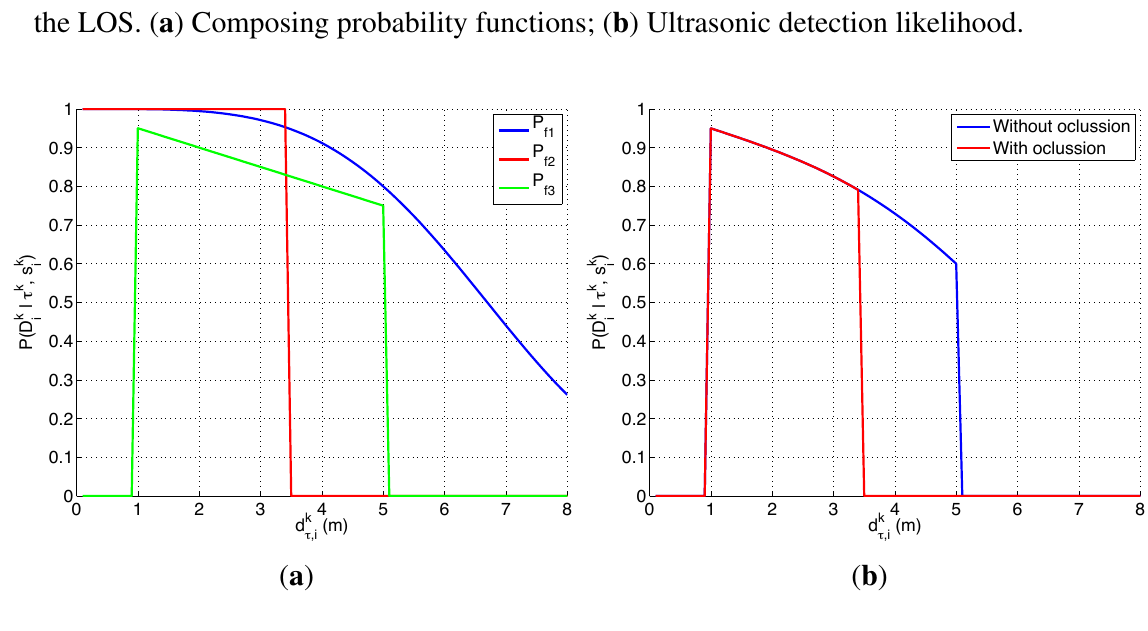
= 10 − 6 , C = 3 . 81 × 10 4 Figure 3. Ultrasonic scanner detection probability curves when P fa (cid:15) ( · ) = 0 . 8 at d k = 5 m), there is an occluding object at 3 . 5 m of the (obtained to make P f 1 τ,i = 1 m, δ = 5 m, and β = 0 . 05 . While Figure 3a shows the composing agent, δ min max curves, Figure 3b shows the detection probability with and without the occluding object in the LOS. ( a ) Composing probability functions; ( b ) Ultrasonic detection